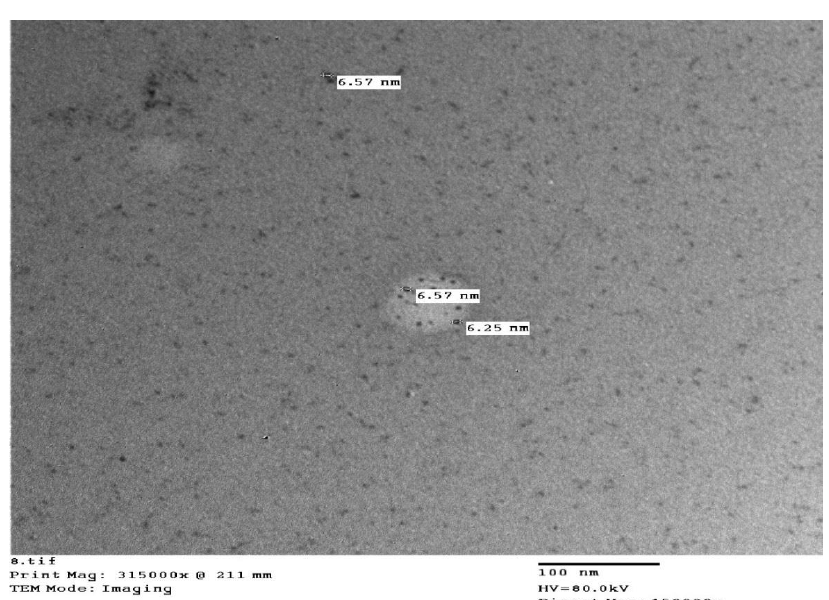
Figure 7. Synthesized magnetite iron nanoparticles under transmission electron microscopy (TEM).